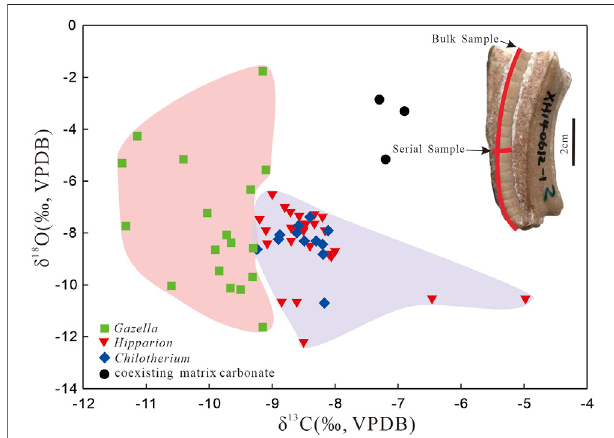
FIGURE 4 | δ 13 C and δ 18 O in tooth enamel of Hipparion fauna (including Hipparion , Chilotherium , and Gazzela ) and their coexisting matrix carbonates (Hough et al., 2011) in the Xunhua Basin.